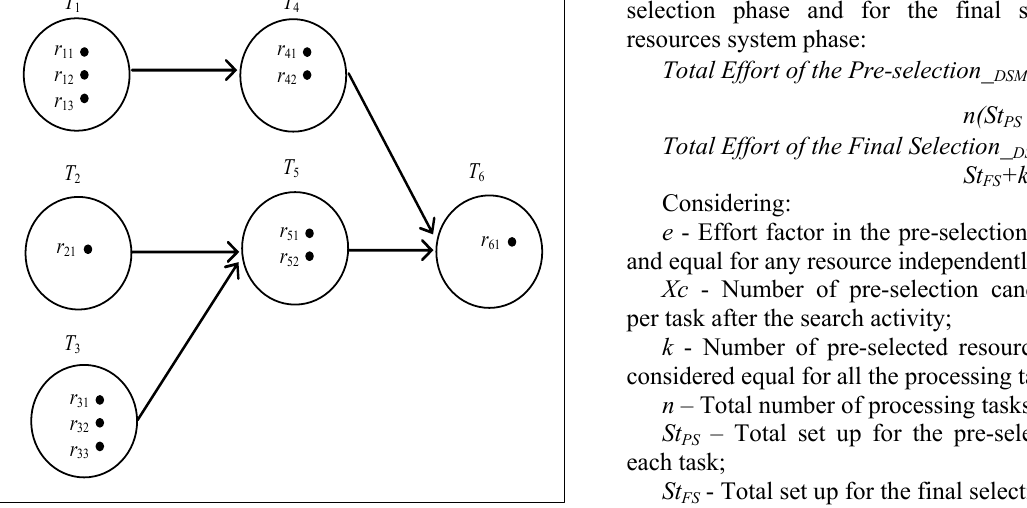
Figure 1. An example of the pre-selected resources for a plan of processing tasks. For each pair of pre-selected resources inside each consecutive processing tasks, there are probably dif– ferent transportation features (distance and consequently time and costs), that can be translated by dashed arrows in Figure 2.